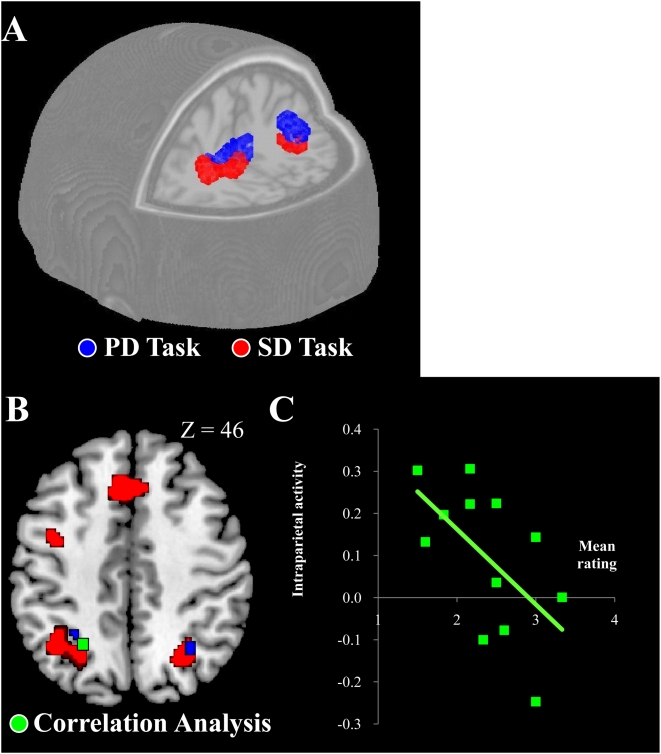
Brain activations during PD and SD, and a representative result from correlation analysis.(A) Blue sections indicate parietal activations for the PD task, identified by the contrast PD vs. PC (control task). These are the only regions identified by this contrast in the entire brain. Red regions correspond to parietal activations for the SD task (SD vs. SC). This panel illustrates only the parietal activations for the SD task. (B) In addition to areas active during the SD (red) and PD (blue) tasks, the green section in the left parietal cortex corresponds to the region whose activity was negatively correlated with the behavioural ratings in the SD task. Horizontal section z = +46 is displayed. (C) Negative correlation between the left intraparietal activity and the ratings in a representative participant (N = 12, r = −0.58, p<0.05). X-axis indicates mean ratings from 12 blocks in the SD task, and Y-axis indicates the corresponding mean level of intraparietal activity (ratio to baseline).